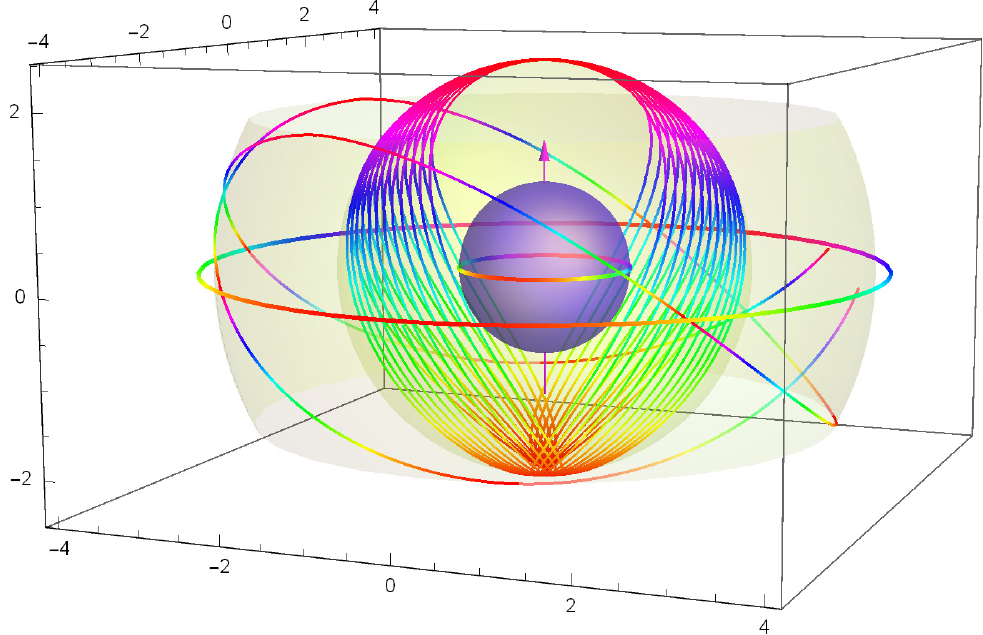
Figure5. ExamplesofphotonspheresinthecaseoftheextremeKerrblackhole( a = 1). Themulticolored curves correspond to spherical photon trajectories with orbital parameters, respectively, ( r , λ , q ) = ( 1,2,0 ) —co-rotating photon in the equatorial plane, ( r , λ , q ) = ( 1 + photon orbit, ( r , λ , q ) = ( 1 + 2 in the equatorial plane.